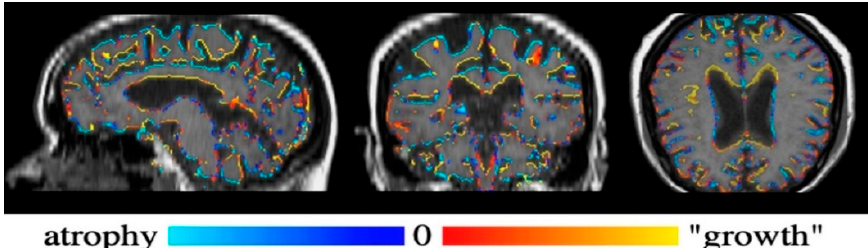
Figure 4. Siena output color-code imaged of the brain. Blue color indicates atrophy; red color indicates growth. Note the prevalence of blue in the grey matter and peripheral grey matter.